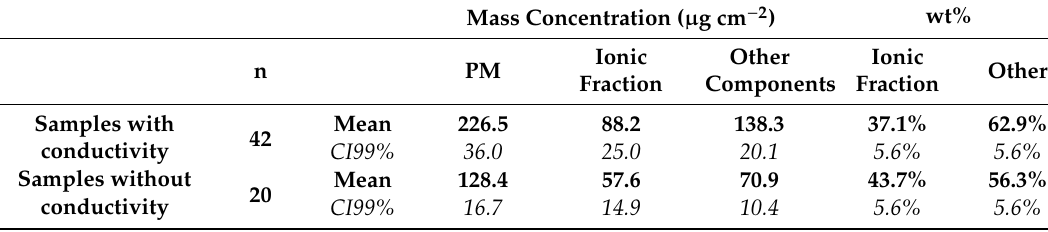
Table 2. The mean mass surficial concentrations for the overall PM 2.5 content, the inorganic ionic fraction (calculated as the sum of F - , Cl - , NO 3- , SO 42- , Na + , NH 4 + , K + , Ca 2 + , Mg 2 + ), the other components (calculated as a di ff erence between the previous two quantities) are presented. Weight percentages (wt%) for the inorganic ionic and the other components are reported, as well. Average values are reported alongside the corresponding 99% confidence intervals. The whole dataset is split into detected and not-detected samples, in relation to the conductivity measurements in the AEC. n indicates the number of samples in each subset. Mass Concentration ( µ g cm − 2 ) wt% Ionic Other Ionic Other n PM Fraction Components Fraction Samples with Mean 226.5 88.2 138.3 37.1% 42 conductivity Samples without Mean 20 conductivity